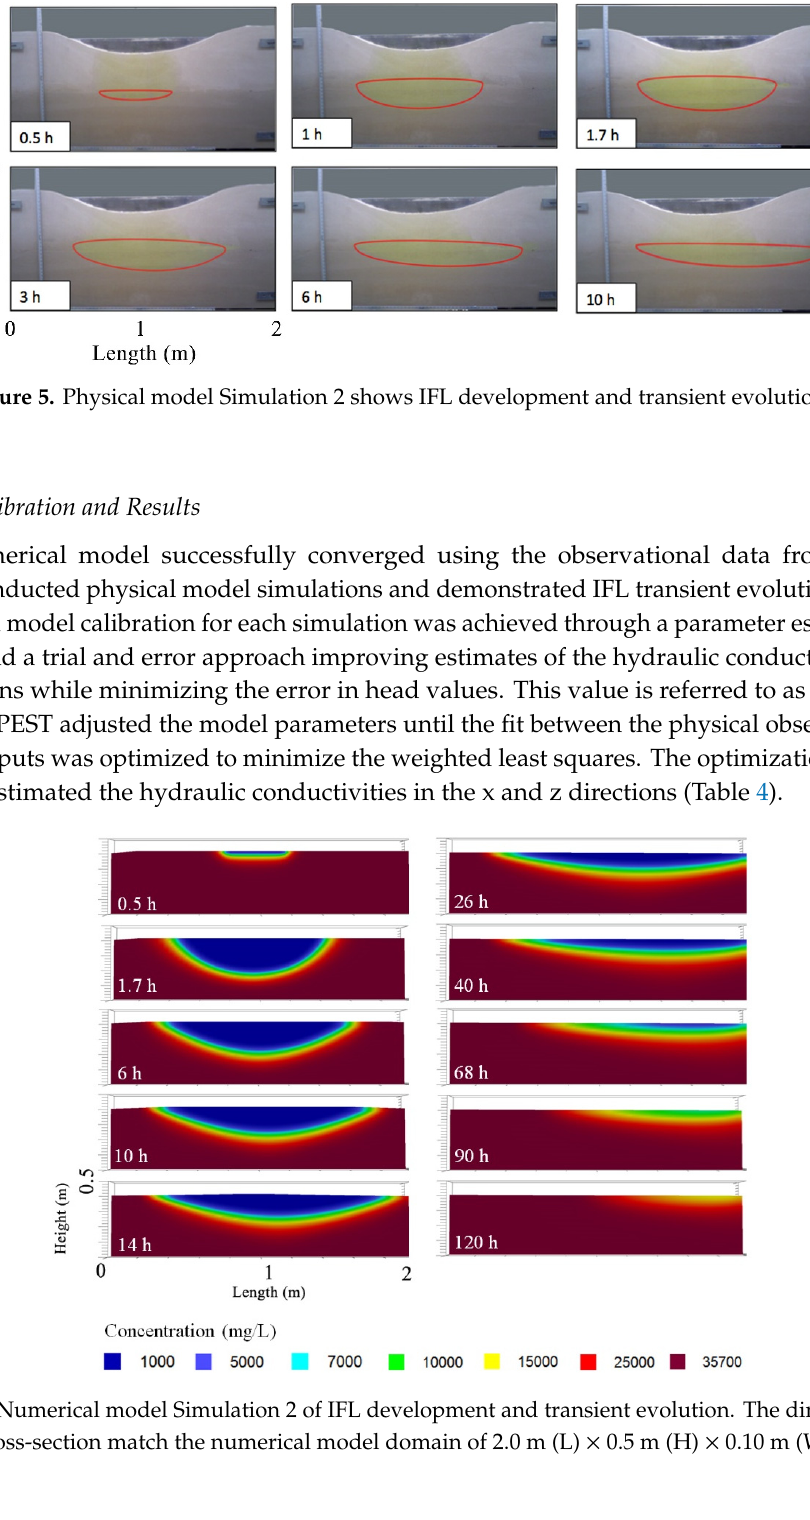
Figure 5. Physical model Simulation 2 shows IFL development and transient evolution. Table 3. The initial recharge rate ( R i ), time of recharge flux ( T q ), time of observed maximum thickness ( T max ), adjusted recharge ( R a ) rates, and stress period times for the numerical model simulations.